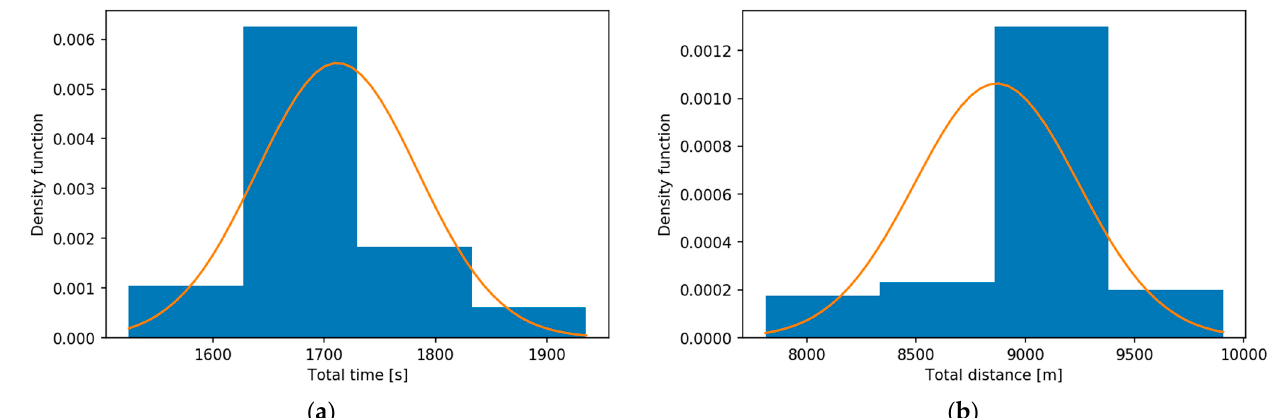
Figure 5. Route with best total travel time achieved from MTSP approach.